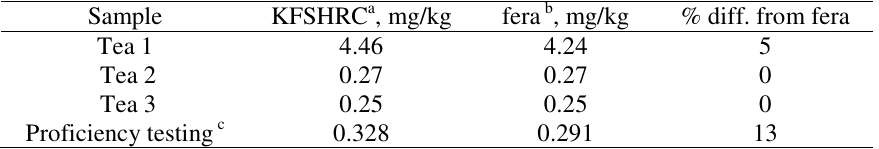
Table 3. Comparison of lead results obtained by KFSHRC and fera laboratories